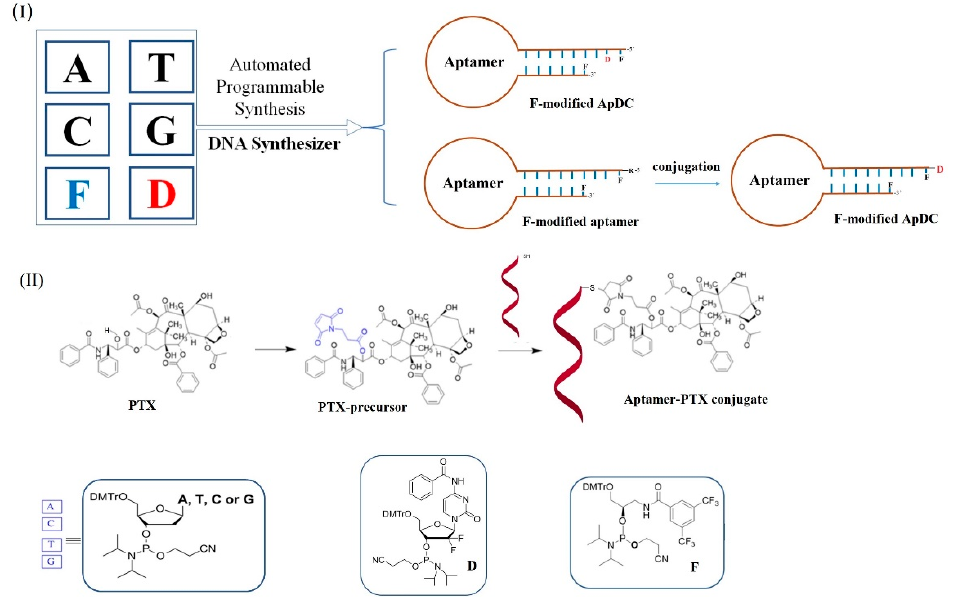
Figure 1. ( I ) Schematic illustration of automated aptamer–drug conjugate synthesis. ( II ) The